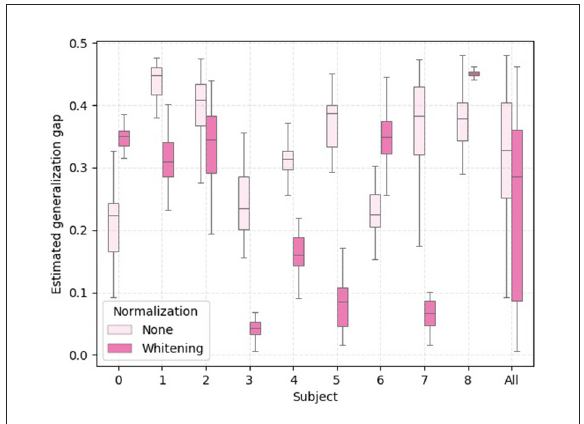
FIGURE7 Boxplot with 30 independent estimates of the generalization gap for the subjects that performed the experiment using a treadmill . The generalization gap is computed as the difference between training and test accuracy using a leave-one-subject-out cross-validation setting.